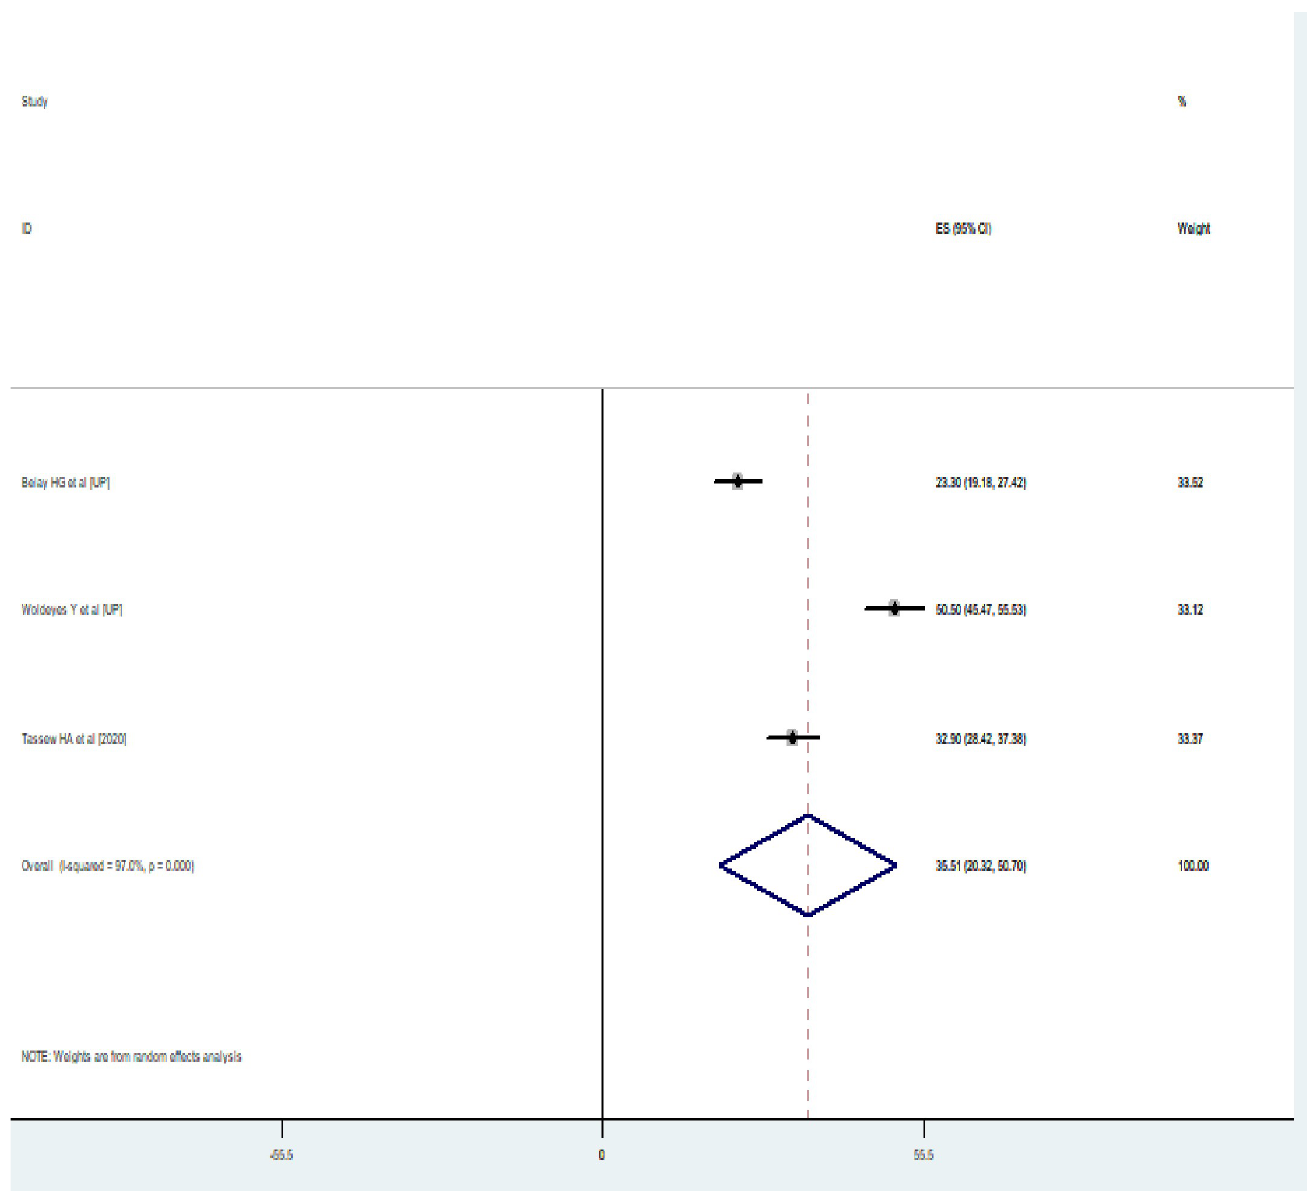
Fig 2. Pooled prevalence of neonatal near miss in Ethiopia.